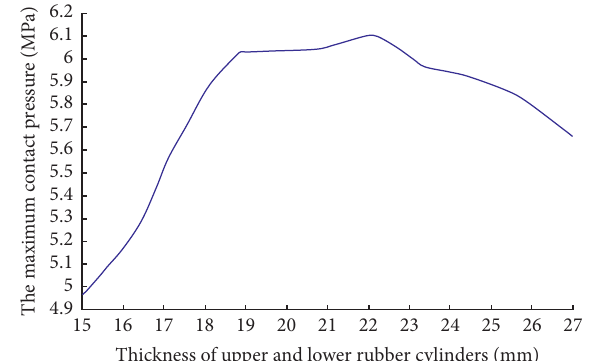
Figure 17: The relationship between the thickness of upper and down rubber cylinders and the maximum contact pressure.